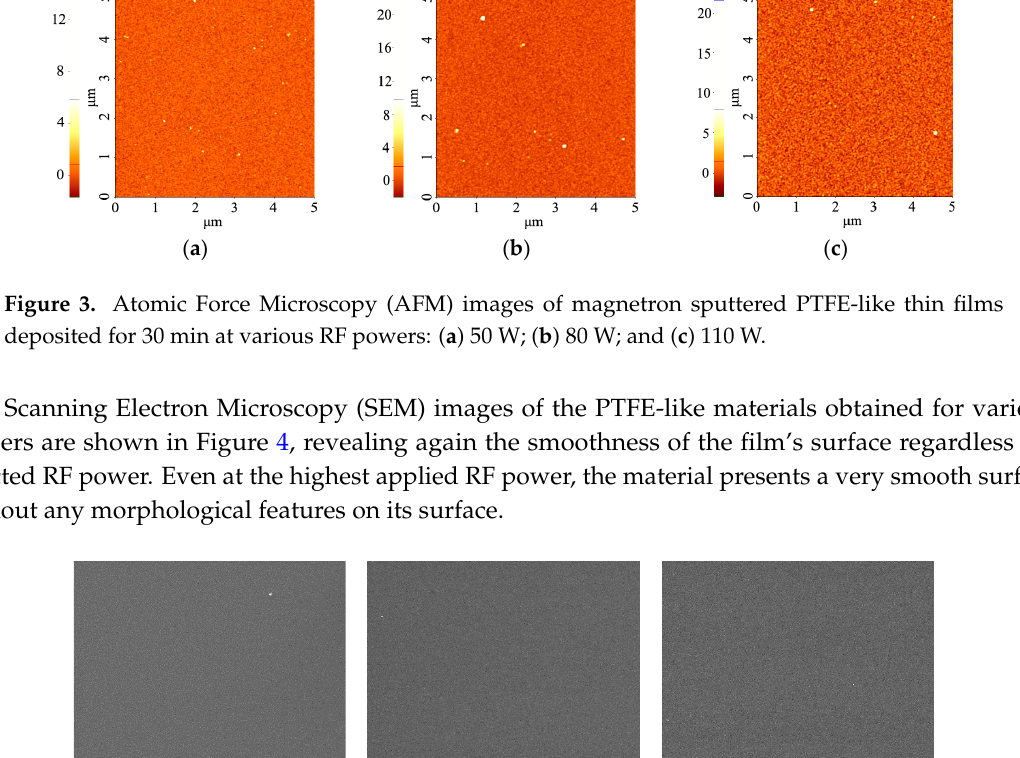
Figure 5. SEM images of carbon nanowalls (CNW) ( a ) as-deposited; and ( b ) covered by PTFE layer deposited by magnetron sputtering.